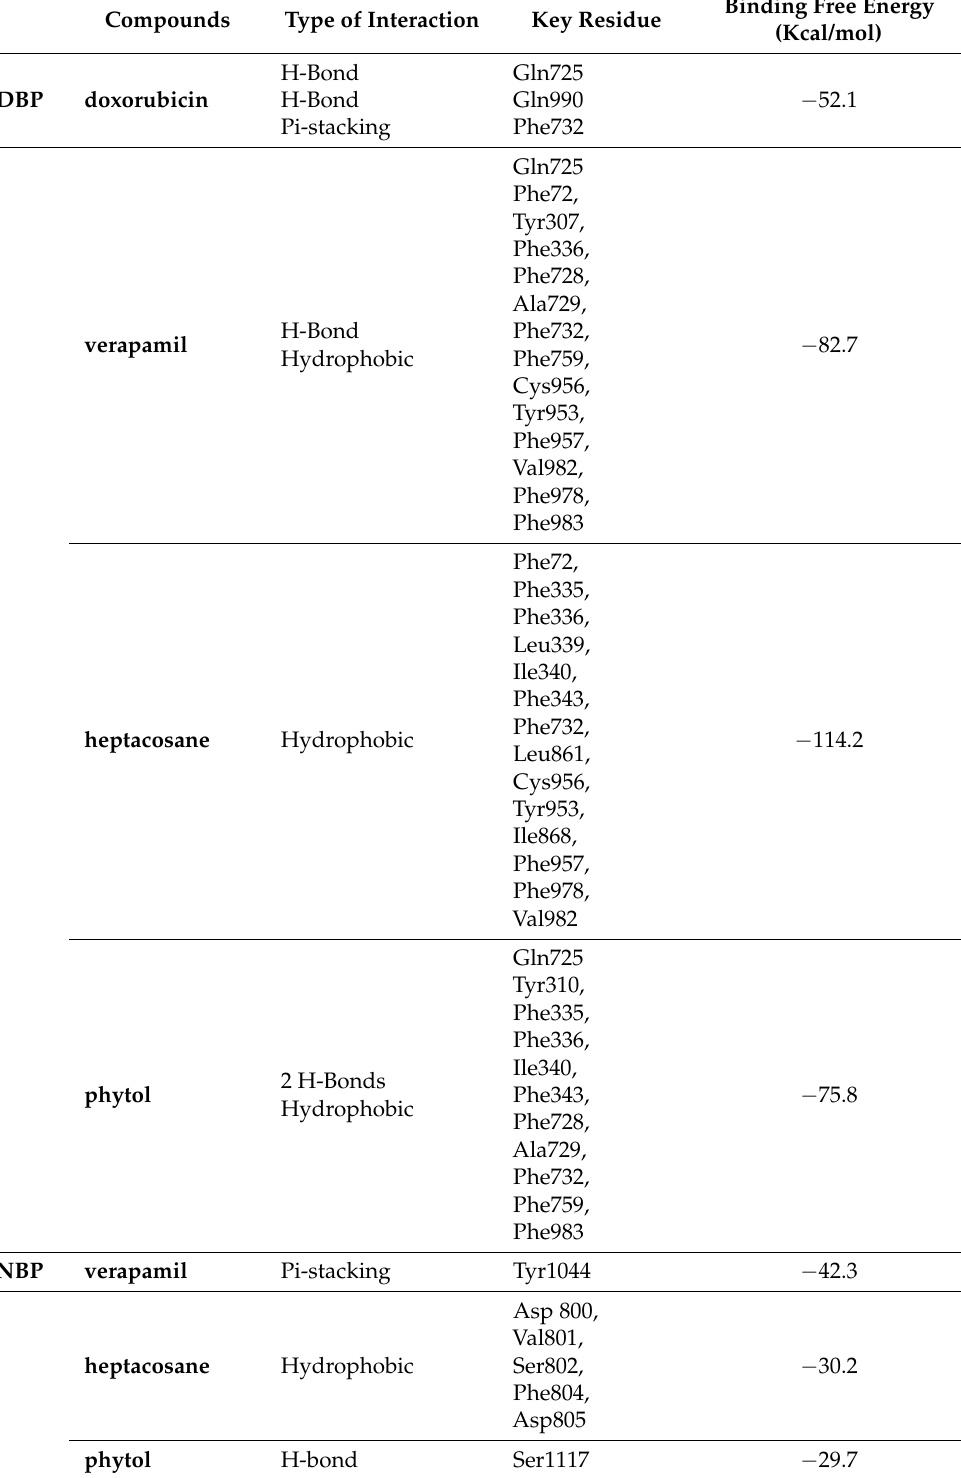
Table 2. Binding free energy, type of interaction and involved key residues for verapamil, doxorubicin, heptacosane and phytol in the predicted binding sites of